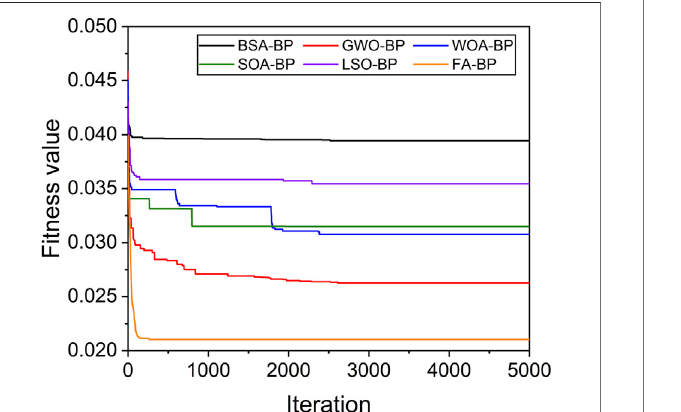
FIGURE 12 | Input volume sensitivity analysis